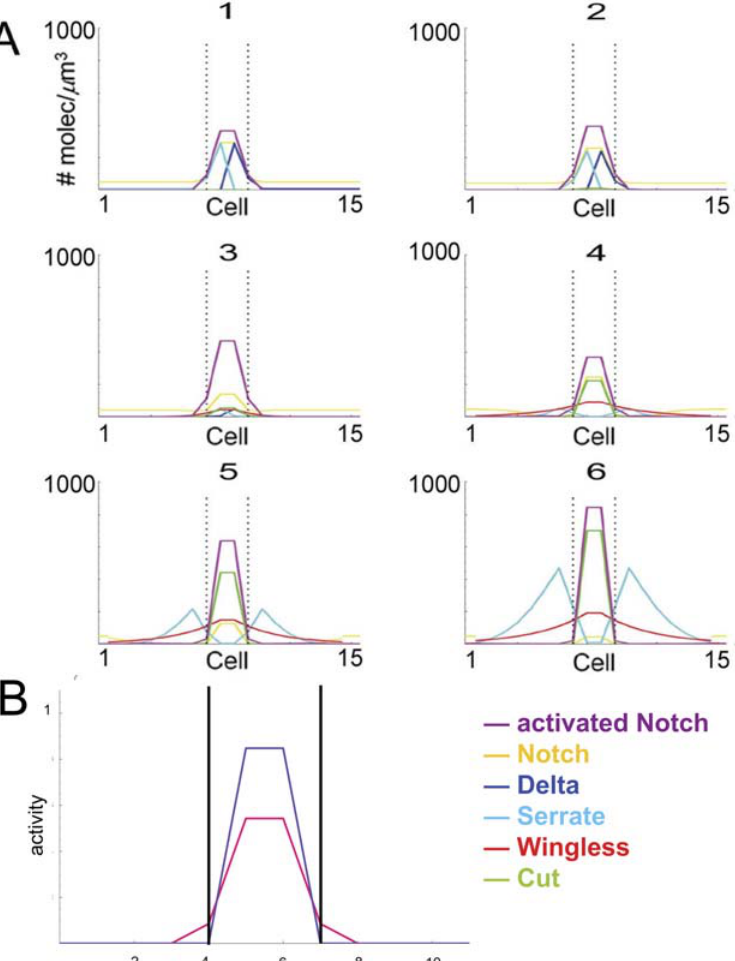
Figure 7. Dynamic process leading to DV boundary establishment and maintenance. (A) Snapshots of the concentration of species versus cell- number along an axis perpendicular to the DV border (dorsal is on the left and ventral on the right). The sequence shows how the expression pattern is generated from the initial condition (1) to the stationary state (6). Frame-to-frame time lapses differ. Dotted lines delimit a four-cell-wide region around the DV boundary and highlight the refinement process (see text). (B) Comparison between the Notch activity domains at different stages (early stages in pink, late stages in purple) that stress the refinement process.